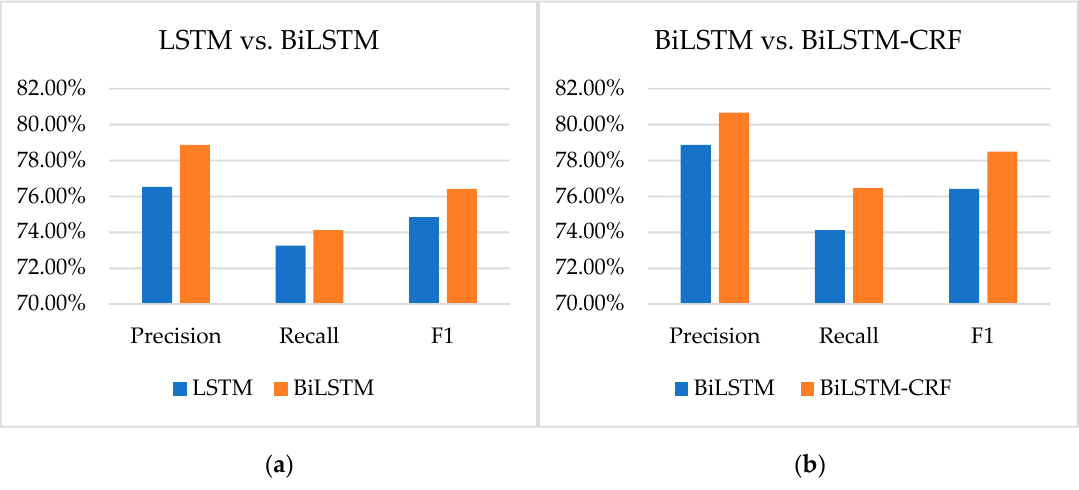
Figure 10. Comparison of histograms of test results, ( a ) on the left, ( b ) on the right, ( a ) LSTM and BiLSTM test comparison histogram and ( b ) BILSTM and BiLSTM-CRF test result comparison.